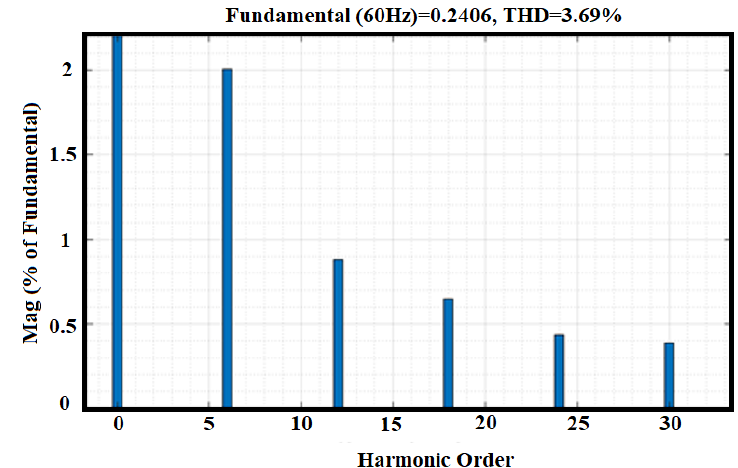
Table 3. Comparative analysis of existing controllers.